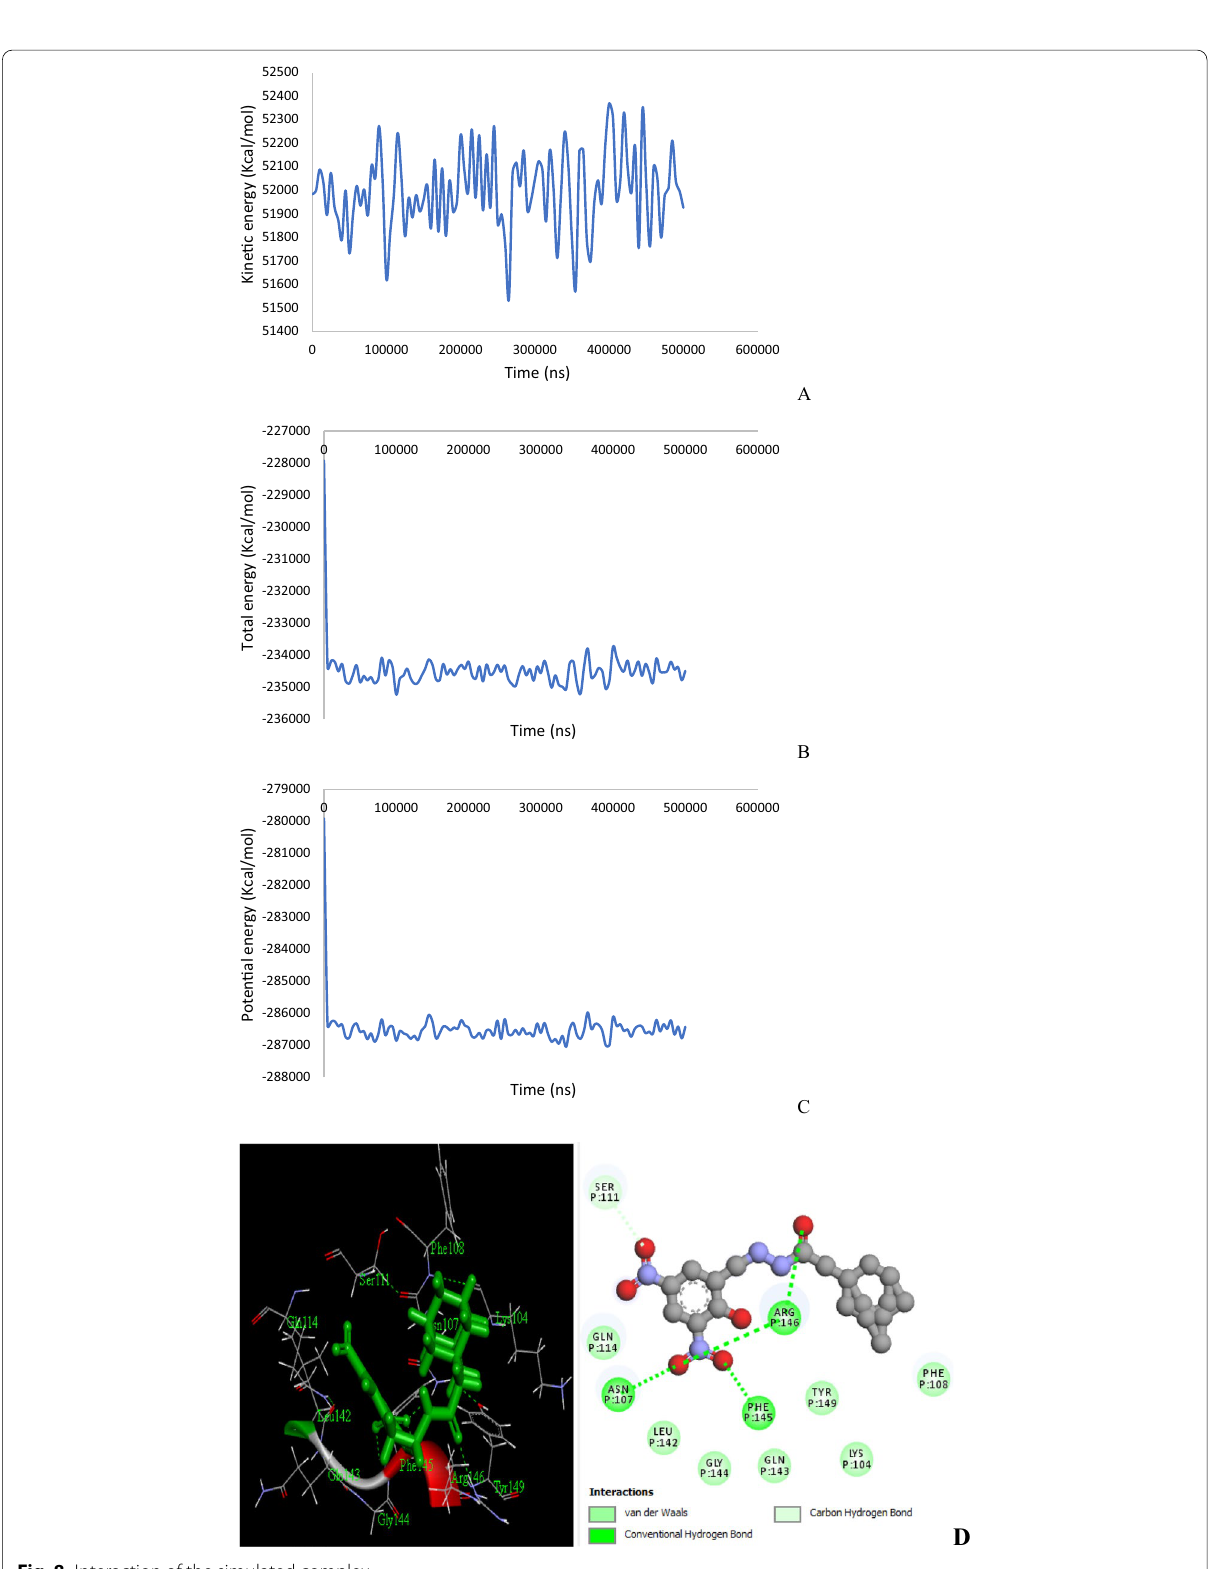
Fig. 8 Interaction of the simulated